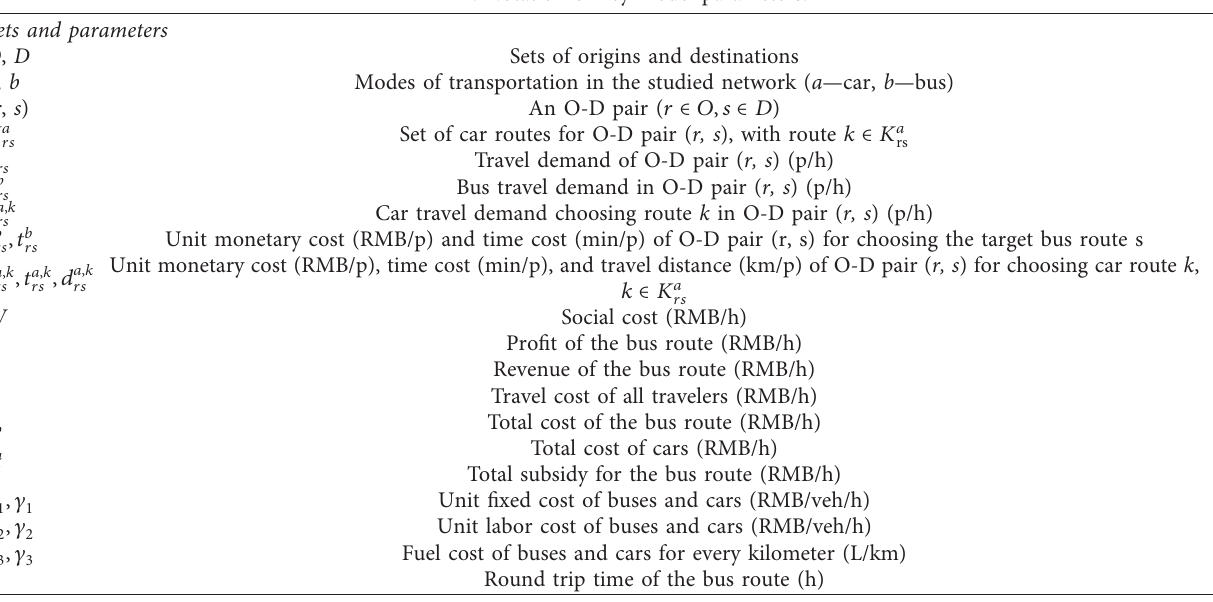
Table 1: Notation of key model parameters.